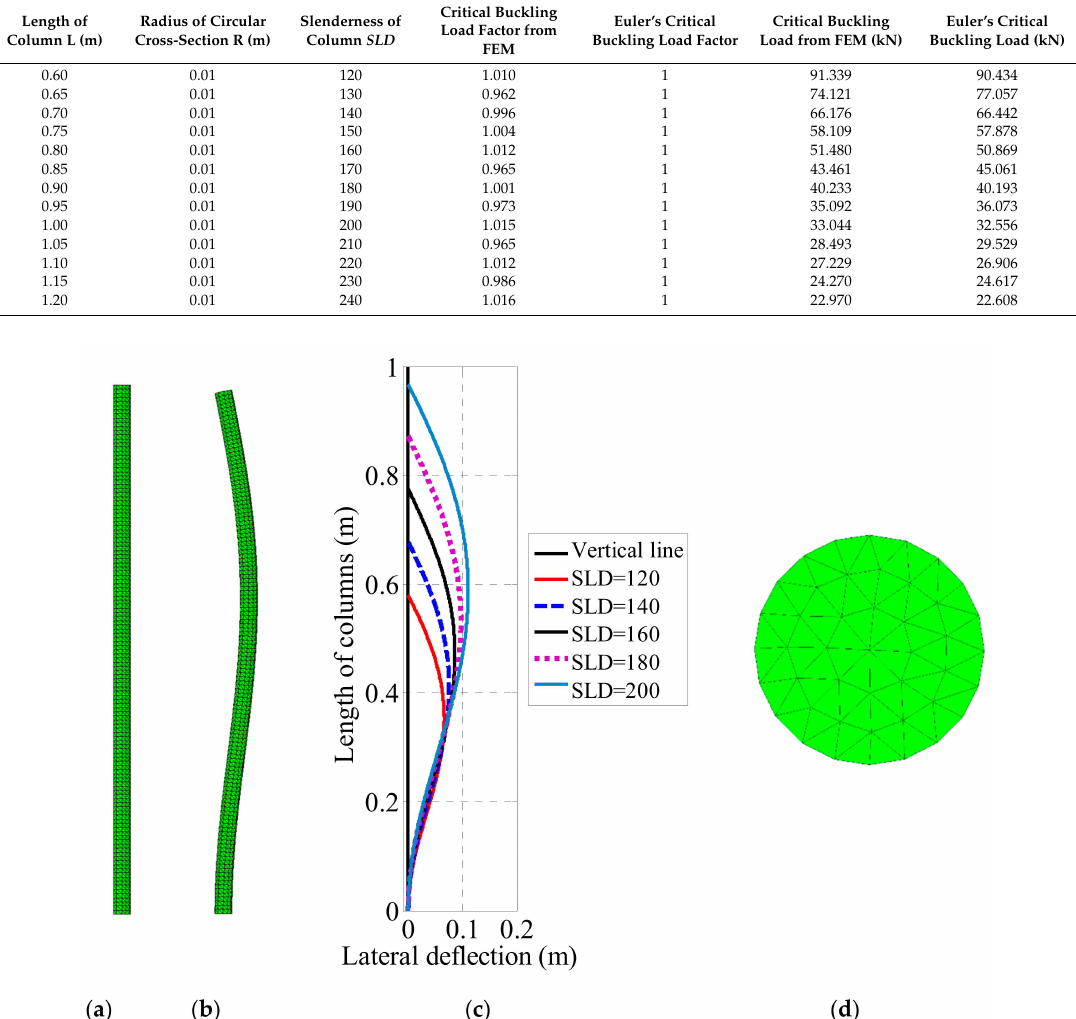
Figure 4. ( a ) Initial and ( b ) deformed tetrahedron meshes of 120 SLD column under axial loading, ( c ) deformed centerline of columns with SLD = 120, 140, 160, 180 and 200, respectively, and ( d ) visualization of the triangular mesh at the top surface for the case SLD =